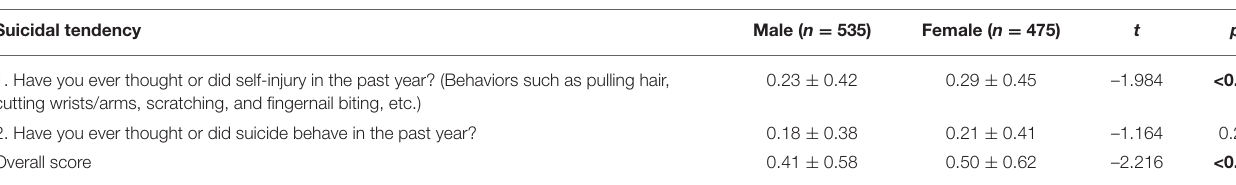
TABLE A3 | Gender difference in ST item scores ( ¯ x ± s